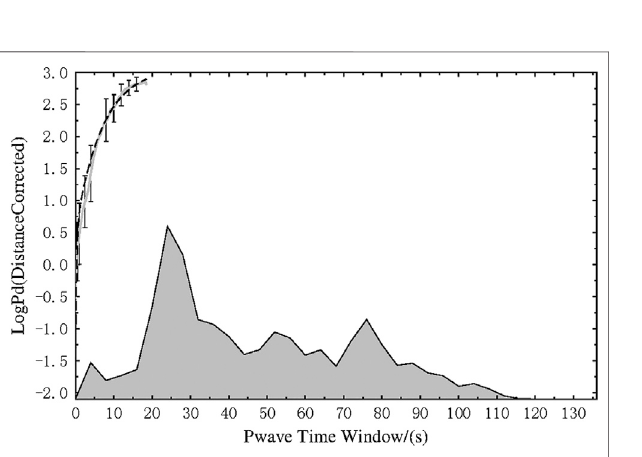
FIGURE3| TheLPDTcurveandthemis fi t. (A) TheaveragepeakamplitudewithdistancecorrectedateachP-wavetimewindowfordifferentmagnitudewithcolor scale. (B) The difference between the observed value and the value from the fi t model. (C) The normalized histograms of the mis fi t value.